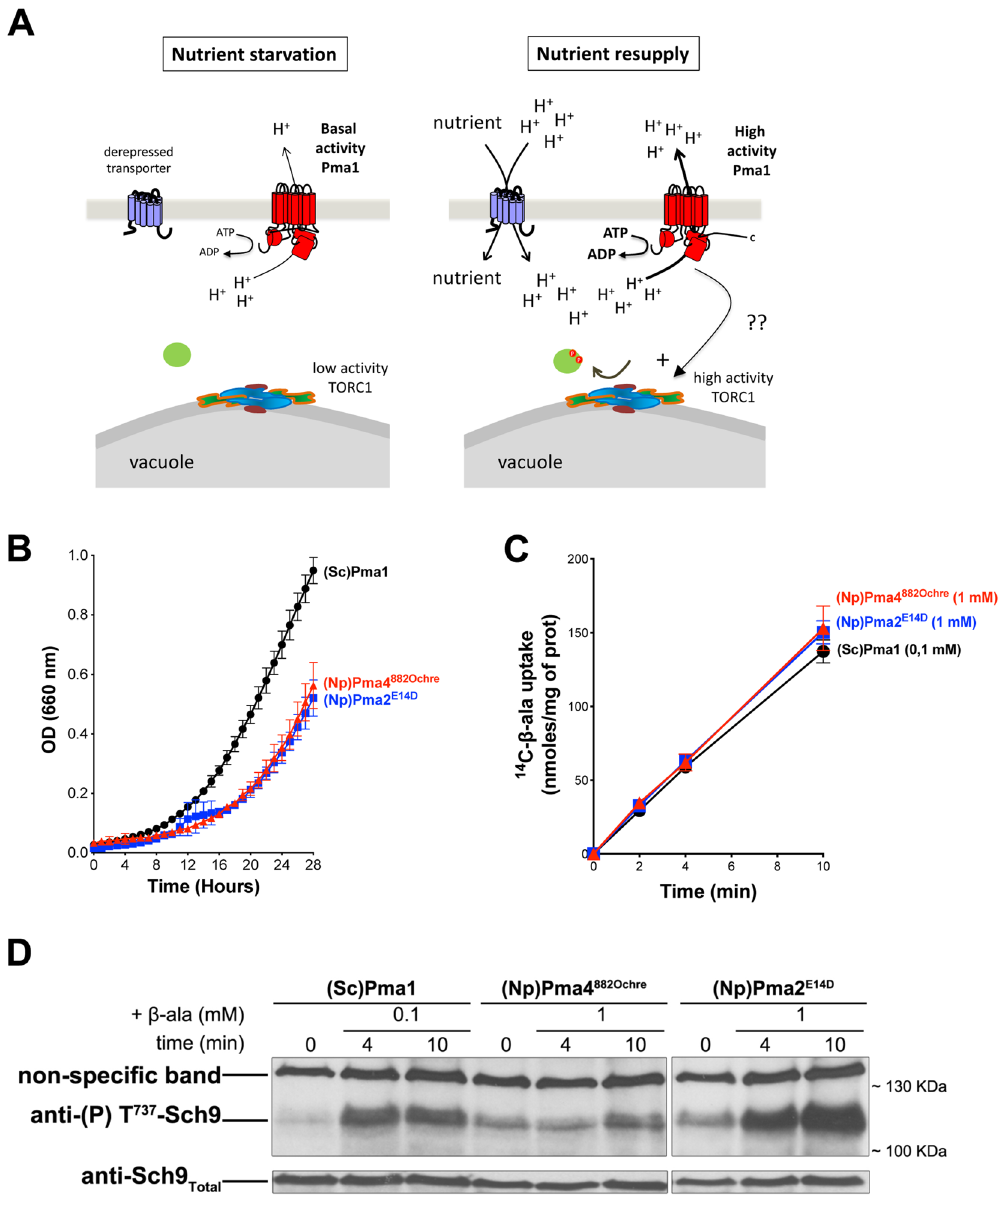
Figure 1. The plant H + -ATPase PMA2 promotes TORC1 activation in yeast. ( A ) Model of TORC1 activation upon H + influx. Left. In cells starved of a specific nutrient, TORC1 activity is low and typically, a high-affinity H + symporter of the limiting nutrient is strongly derepressed (e.g. Gap1, Pho84, or Sul1 in cells starved of nitrogen, phosphate, or sulfur, respectively). In these cells, the plasma-membrane Pma1 H + -ATPase displays basal activity. Right. When cells are resupplied with the limiting nutrient, a strong nutrient-uptake-coupled influx of H + occurs. This rapidly stimulates the activity of Pma1, which extrudes excess H + . In this high-activity state, Pma1 also plays an active role in transient re-activation of TORC1, possibly via signaling. ( B ) GAL1p-PMA1 pma2Δ cells expressing, from two plasmids, either (Sc)Pma1, (Np)PMA4 882Ochre , or (Np)PMA2 E14D along with HA-NPR1, were grown on Gluc NH 4+ medium in a microplate reader for 28 h. Data points represent averages of the OD at 660 nm of two biological replicates; error bars represent SD. ( C ) Strains as in B were grown on Gluc NH 4+ medium. After a shift to Gluc proline medium for four hours, [ 14 C]-β-alanine (0.1 or 1 mM) was added to the medium before measuring the incorporated radioactivity at various times. Average values of three biological replicates are shown, and error bars correspond to SD. ( D ) Strains and growth conditions as in C. Cells were collected before and 4 and 10 min after addition of β-alanine (0.1 or 1 mM). Crude extracts were prepared and immunoblotted with anti-(P) T 737 -Sch9 and anti-Sch9 Total antibodies. The detected signals are from the same gel and exposure times were identical. Two parts of the gel were grouped for presentation convenience. The original blot is presented in Fig.